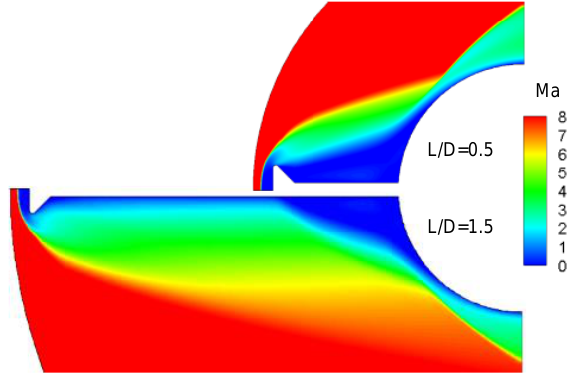
Figure 15. Effect of the length of the spike on flow field.